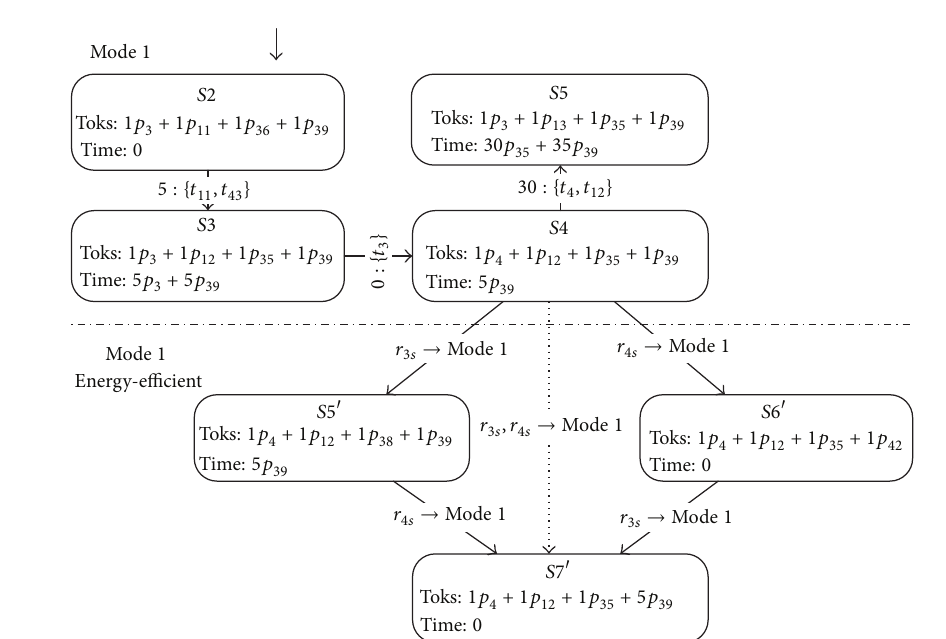
Figure 6: State transition graph of Example